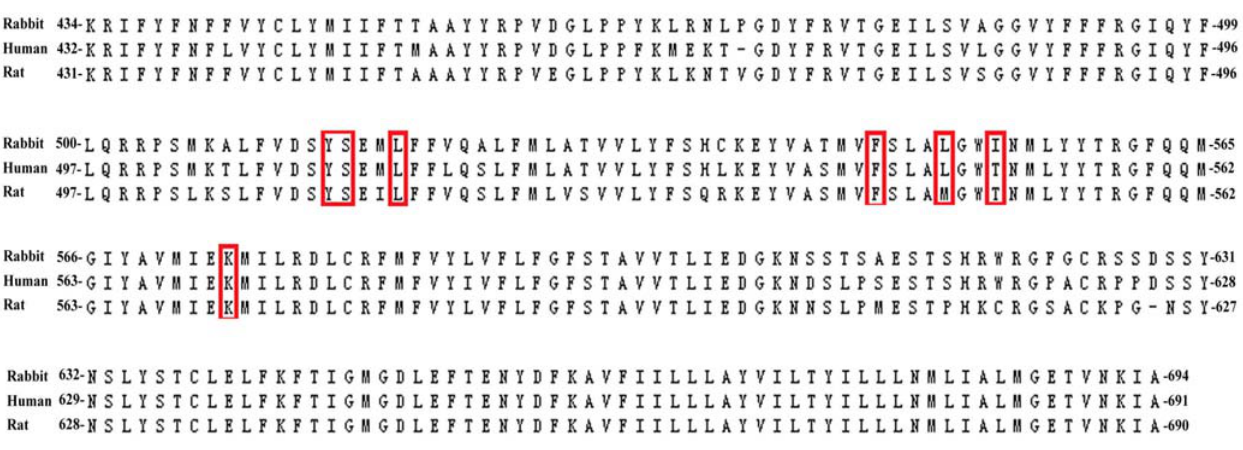
Figure 2. Sequence alignment of rabbit, human and rat Transient receptor potential vanilloid-1